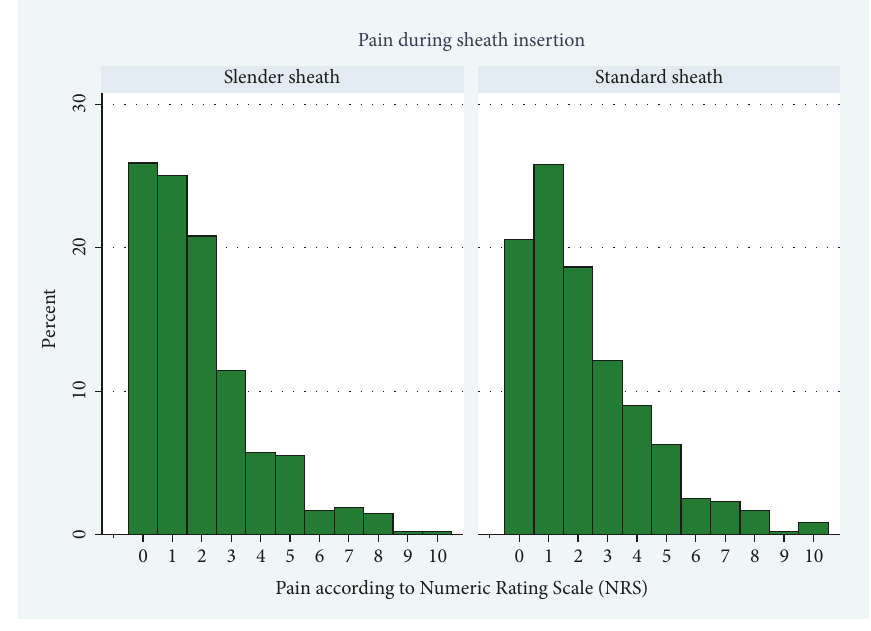
Figure 3: Pain during sheath insertion. Table 2: Outcomes among patients treated with Slender versus Standard sheath during coronary angiography or percutaneous coronary intervention. Valid cases Slender sheath Standard sheath